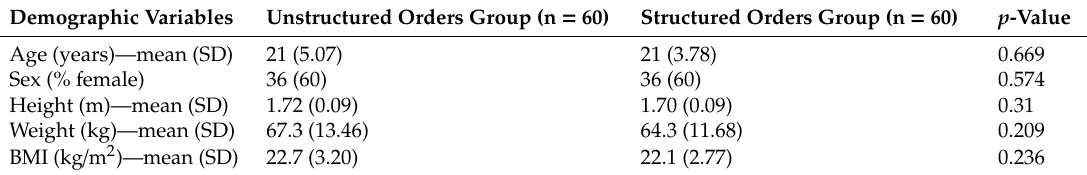
Table 1. Baseline demographics (n = 120).